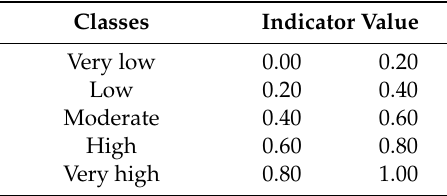
Table 3. Flood risk indicators